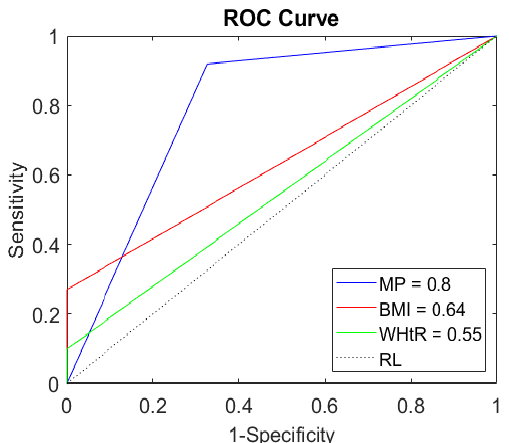
Figure 3. Area under Receiver Operating Characteristic demonstrating the abilities of discrimination of the model and of the anthropometric indicators in the prediction of high body fat in adolescents in the dataset. Abbreviations: MP—proposed method; WHtR—waist-to-height ratio; BMI—body mass index; RL—reference line.